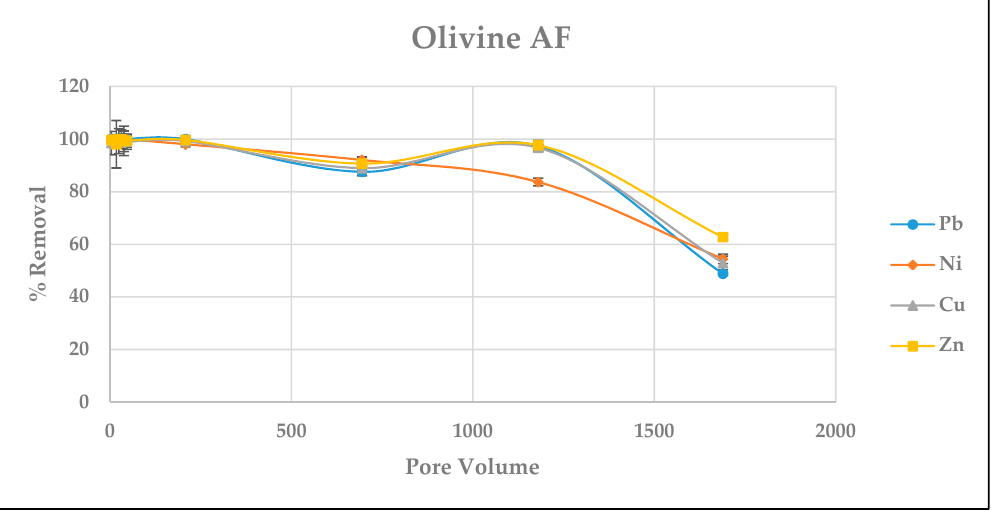
Figure 3. Percentage removal of the four metals by olivine amended filters as a function of pore volume. AF stands for amended filter.